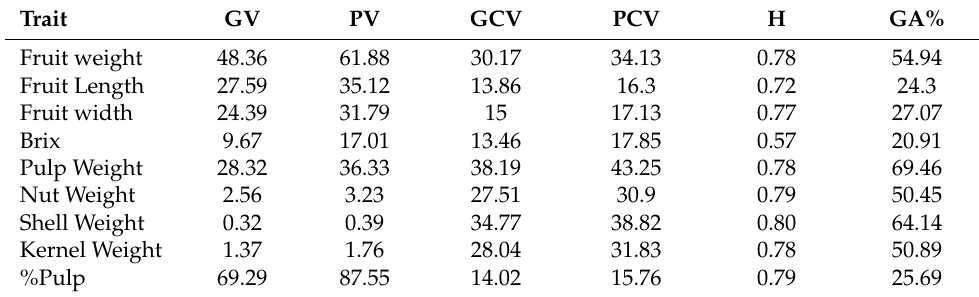
Table 3. Genotypic and phenotypic variability, heritability and genetic advance